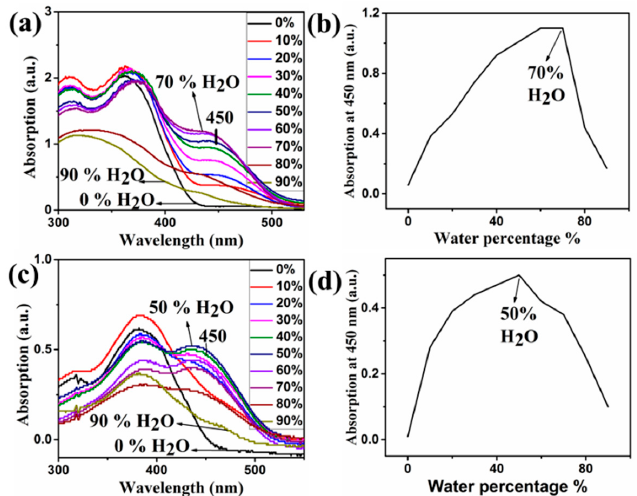
Figure 1. ( a , b ) UV-vis spectra of the absorbance of 1 and plot of absorbance measured as a function of water concentration at 450 nm; ( c , d ) UV-vis spectra and absorbance of 2 measured at 450 nm as a function of water percent in graphical representation.